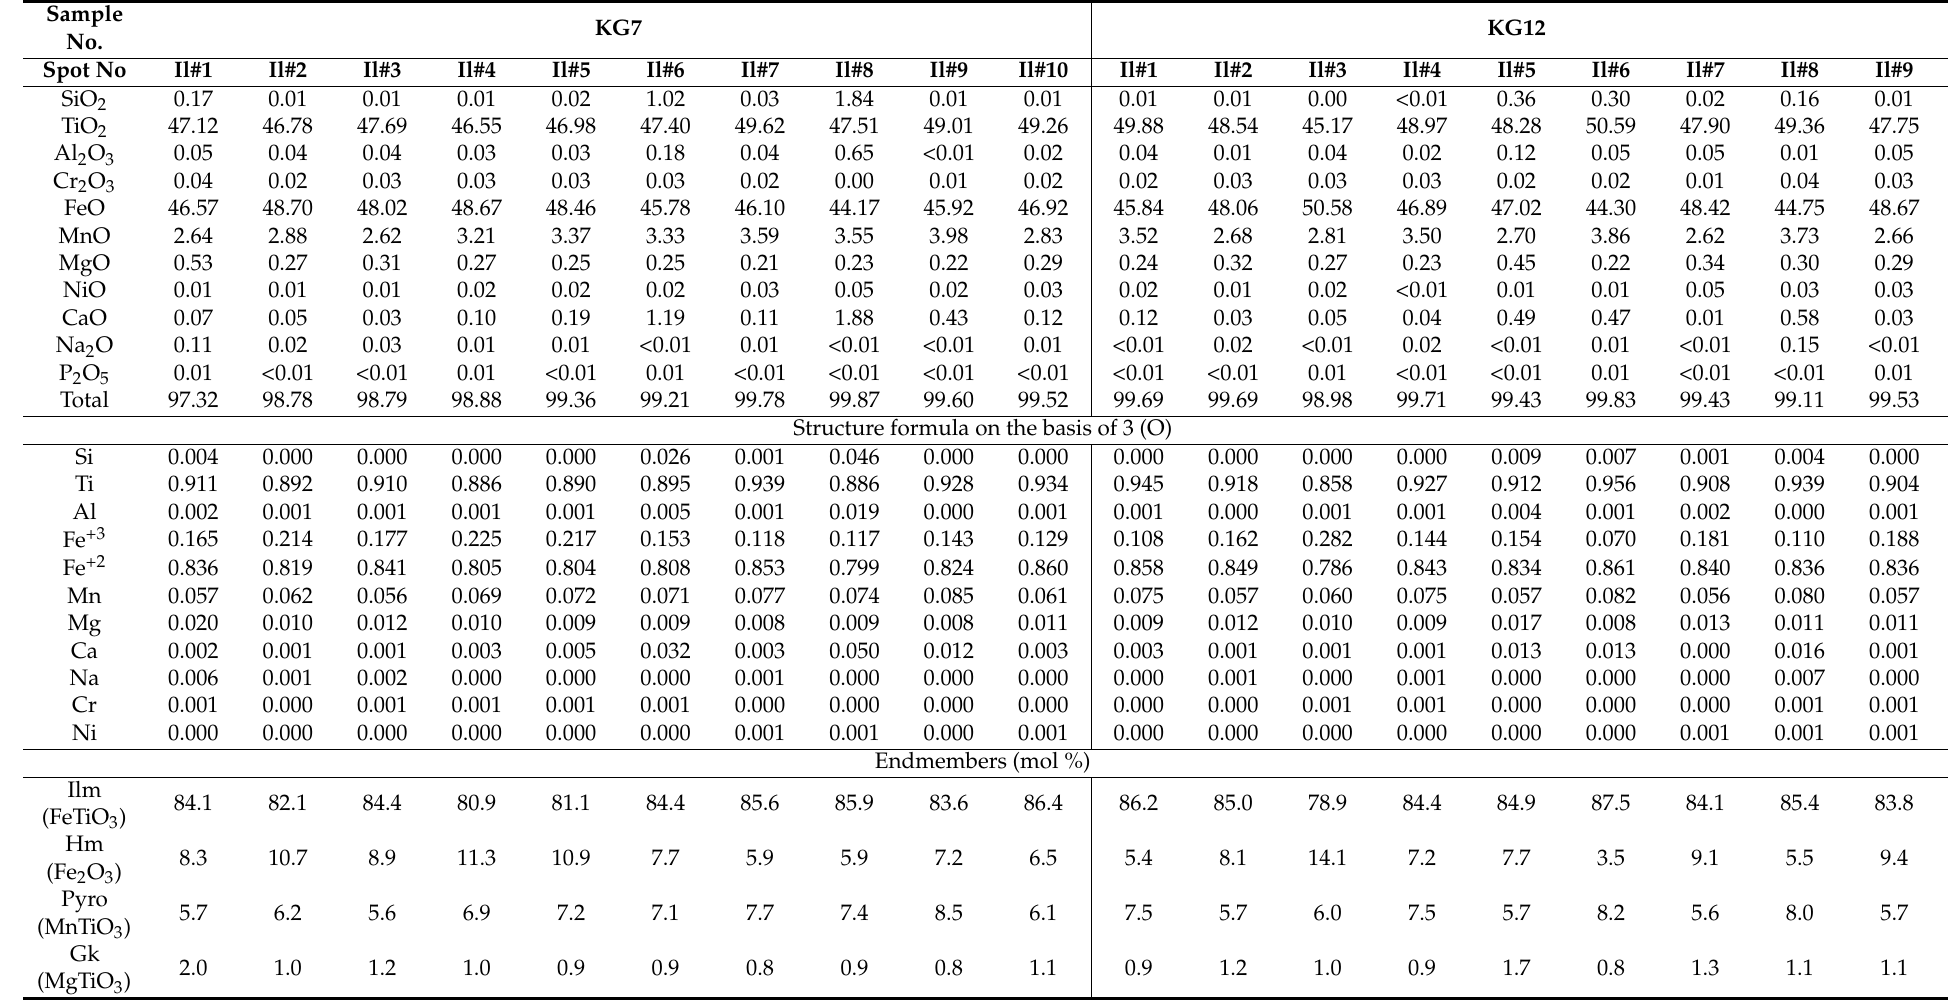
Table 4. Microprobe analyses of ilmenite rims around loveringite in the olivine gabbro of the Khamal mafic